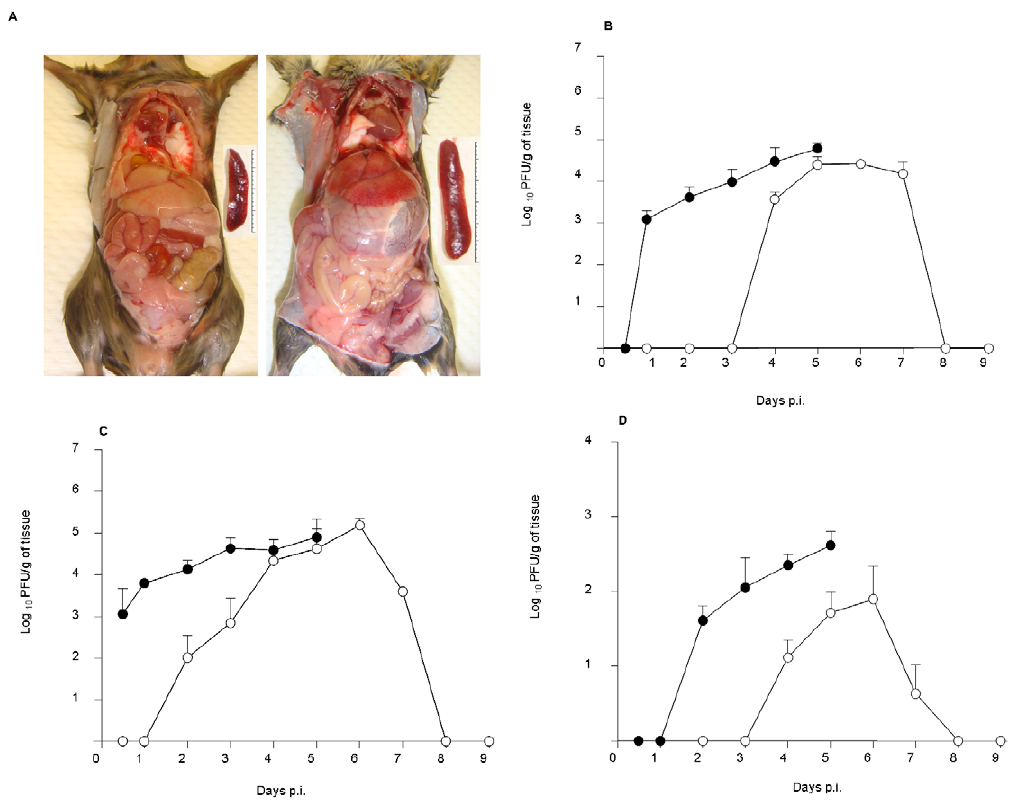
Figure 4. Pathology and virus titres in the liver, spleen and brain of D2Y98P-infected mice. (A) Mice were ip. infected with 10 7 PFU of D2Y98P, and were sacrificed at moribund state and perfused extensively with PBS. Representative gross appearance of organs in the intraperitoneal cavity of uninfected (left panel) and ip. infected (right panel) mice. Insets highlight the difference in the spleen size between both animal groups. Virus titres were determined in the liver (B), spleen (C) and brain (D) from AG129 mice ip. infected with 10 7 (black circle) or 10 4 (open circle) PFU of D2Y98P virus. Results are expressed as log 10 [mean 6 SD] in PFU per gram of tissue. Five mice per time point per group were assessed. Results are representative of 2 independent experiments.